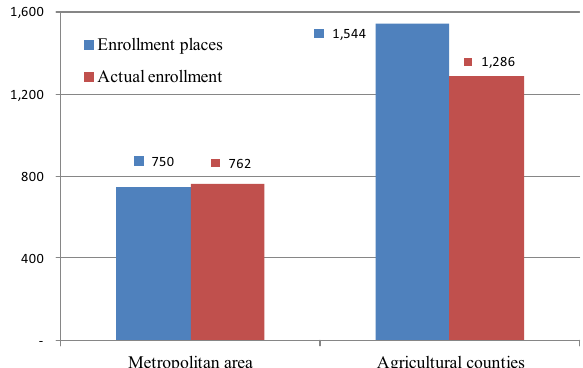
Fig. 1 A bar chart comparing enrollments. A bar chart of enrollment places and actual enrollment in the exam-free admissions schools of the metropolitan area and agricultural